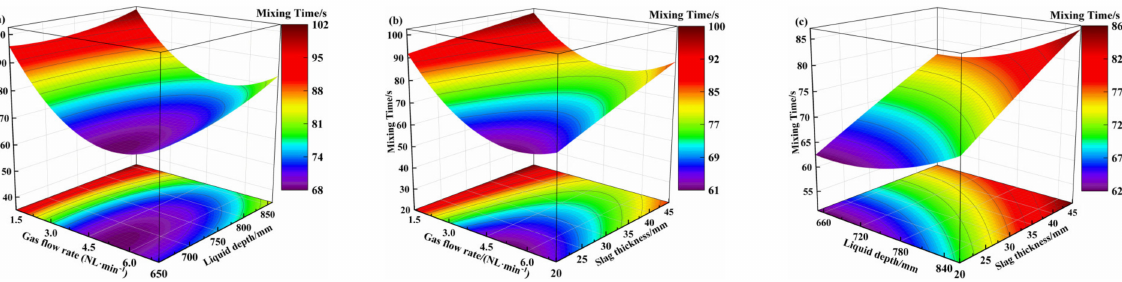
Figure 9. The 3D response surface diagram of MT under the interaction of ( a ) gas flow rate and liquid depth, ( b ) gas flow rate and slag depth, ( c ) liquid depth and slag